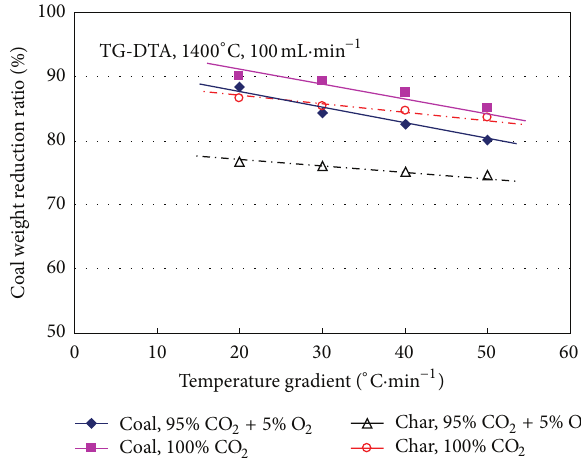
Figure 27: Comparisons of weight reduction ratio versus tempera- ture gradient between coal and char.